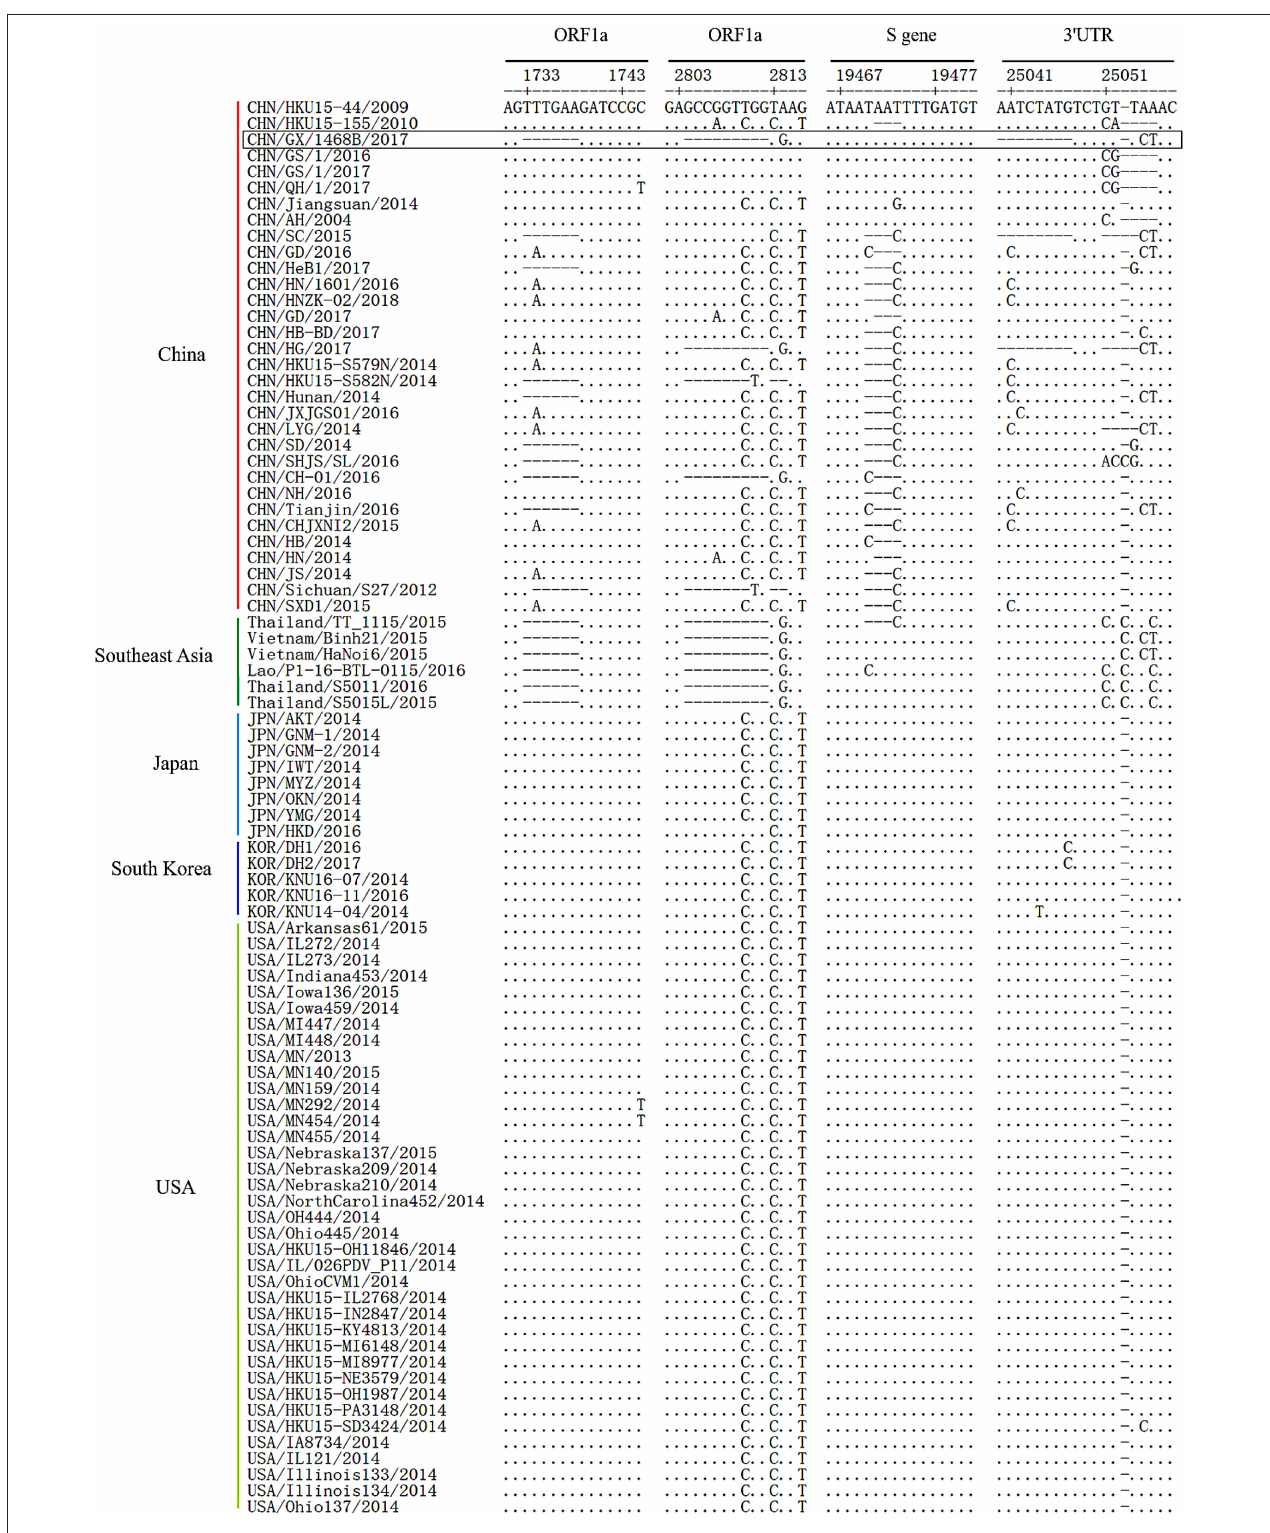
FIGURE 1 | Genome deletions or insertions identified in the complete sequence alignment of PDCoV strains. Sequence alignments of PDCoV strains from different countries by using EditSeq and MegAlign in DNAStar Lasergene Version 7 software packages. The dots ( • ) and dashes (–), respectively, indicate the exact nucleotide matches or deletions compared to the CHN/HKU15-44/2009 strain, while the boxes indicate the main deletions and insertions in the PDCoV CHN/GX/1468B/2017 strain.